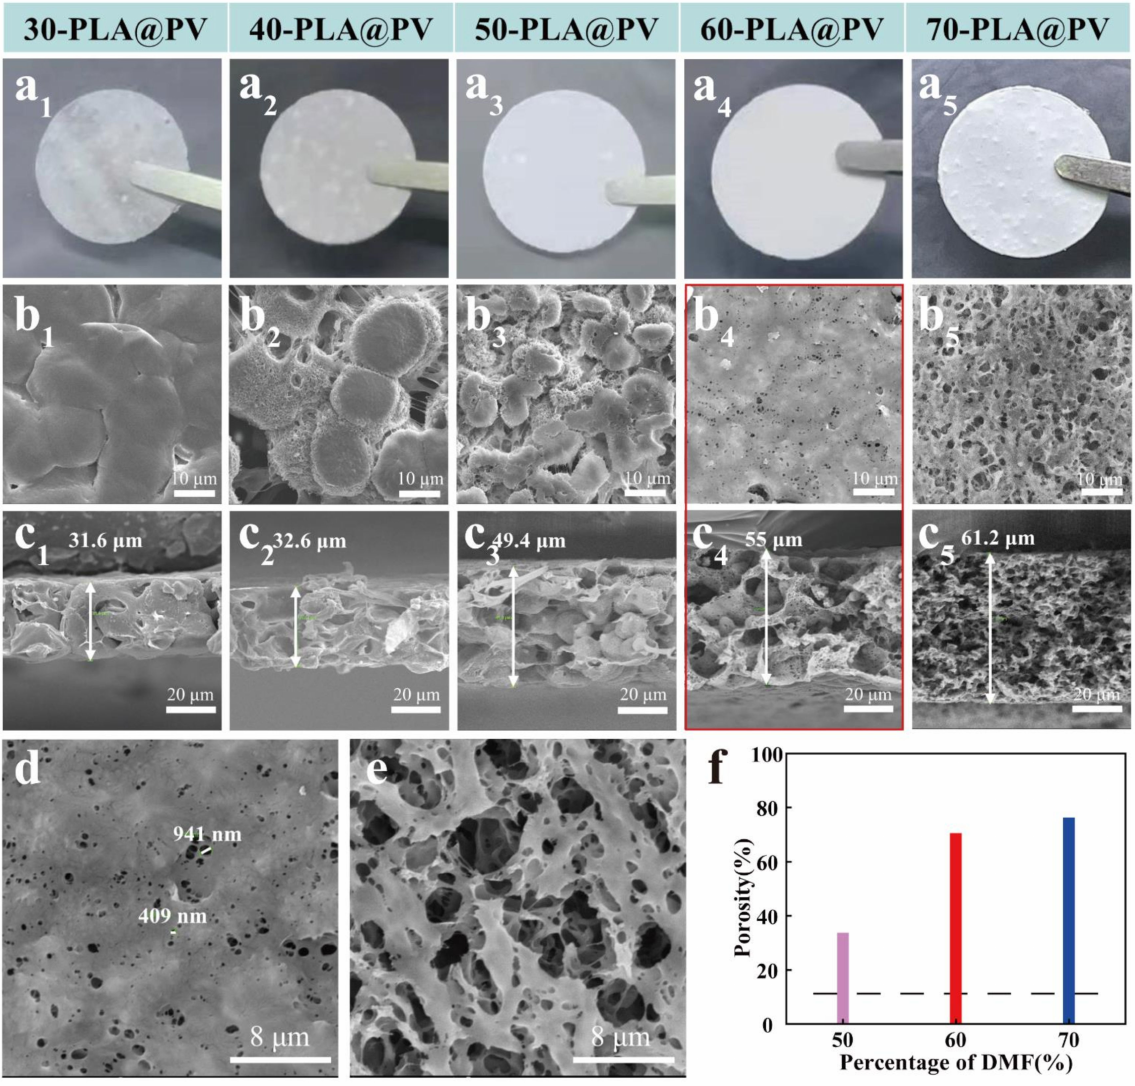
Figure 2. ( a 1 – a 5 ) Digital images of five membranes prepared with various ratios of DMF and DCM. ( b 1 – e ) SEM images: surface ( b 1 –b 5 , d , e ) and cross-section ( c 1 –c 5 ) images of five